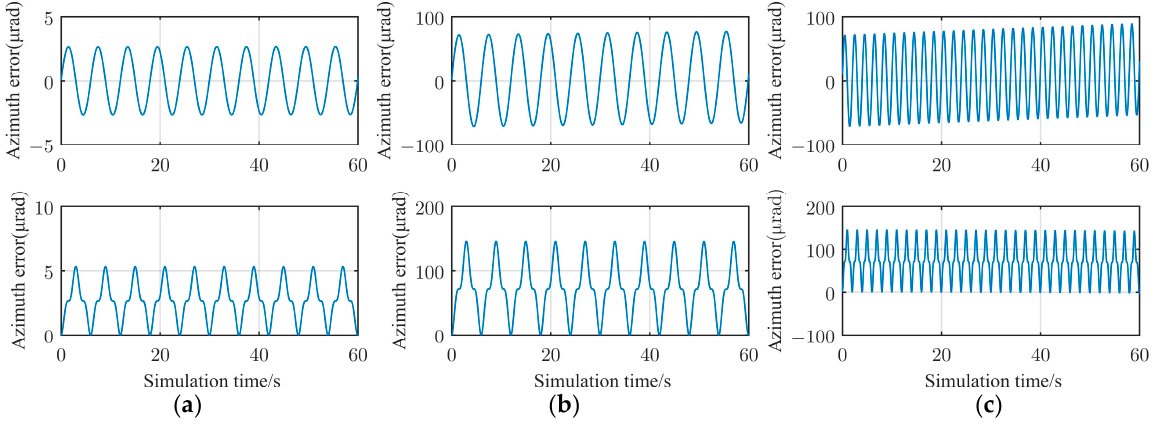
Figure 19. The error curve of the calculation of the direct numerical calculation method. ( a ) a = 1°, ω = 60°/s; ( b ) a = 3°, ω = 60°/s; ( c ) a = 1°, ω = 180°/s. ω = 60 ◦ /s; ( b ) a = 3 ◦ , ω = 60 ◦ /s; ( c ) a = 1 ◦ , ω = 180 ◦ /s.